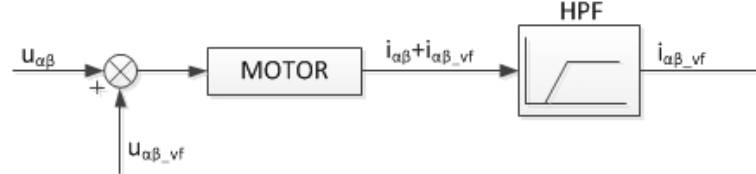
Figure 7. Block diagram of HF signal injecting .